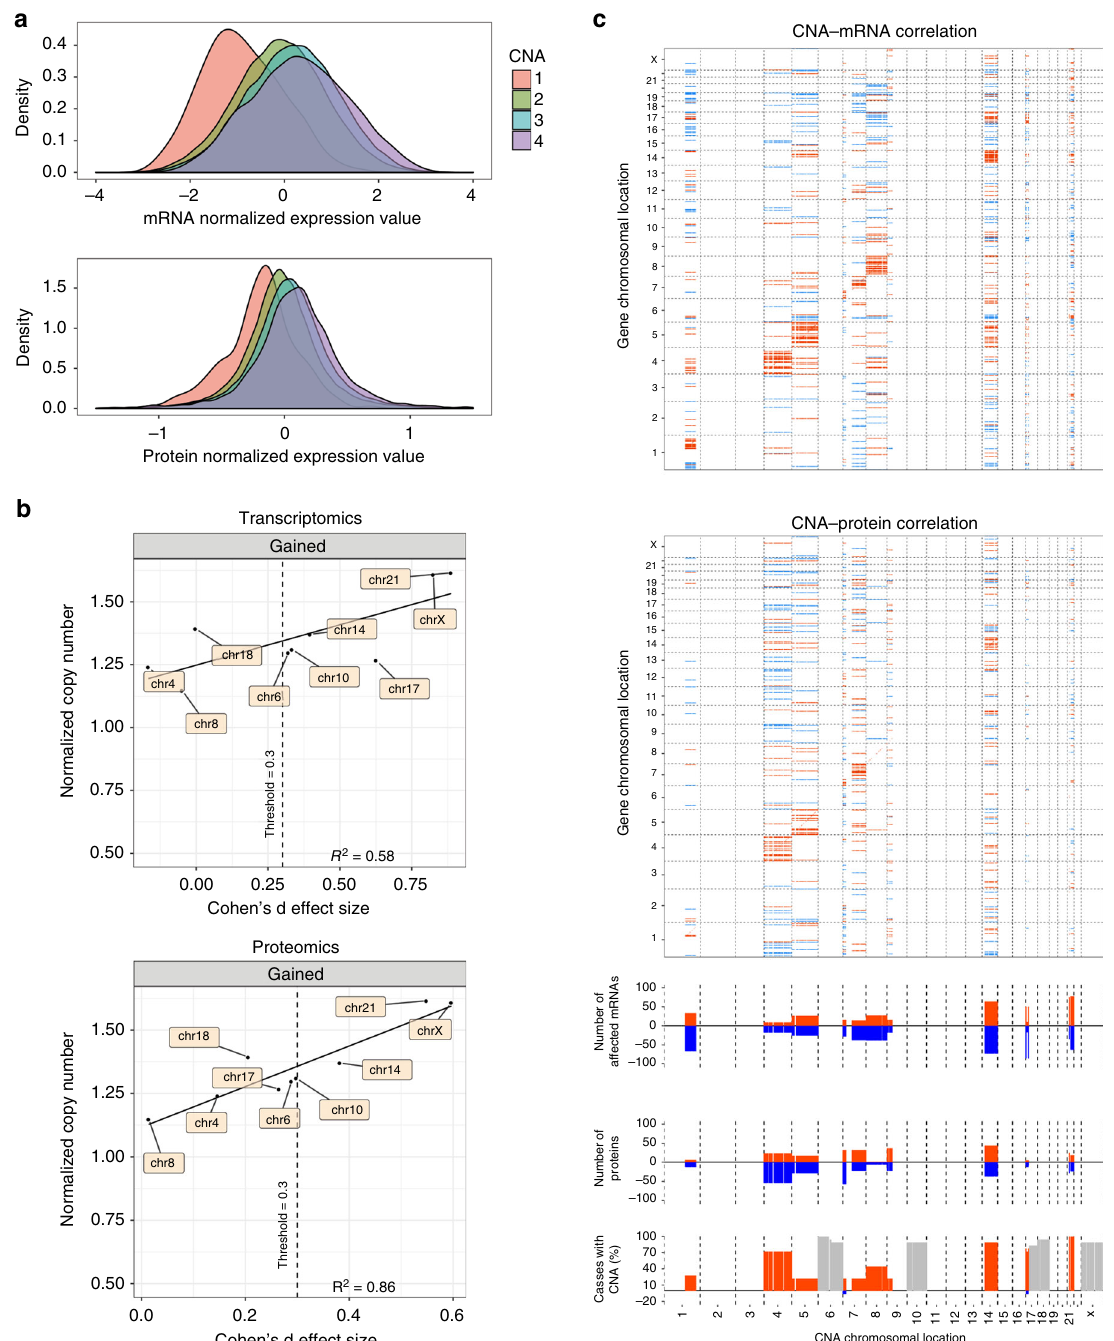
Fig. 2 Effects of copy number alterations on mRNA and protein abundance. a Dosage effects in 18 high hyperdiploid ALL at the RNA and protein levels. The effects were lower on the protein level than on RNA level, showing additional layers of control for protein expression. b Cohen ’ s d effect size analysis of gained chromosomes in high hyperdiploid vs. ETV6 / RUNX1 -positive leukemia. c cis and trans effects of copy number changes in 18 cases of hyperdiploid childhood B-cell precursor acute lymphoblastic leukemia. Correlations of copy number aberrations (CNA) ( x -axes) to RNA (top) and protein (bottom) expression levels ( y -axes) are shown. Note that a large fraction of the genome was not included in the analysis since there was no copy number variance, either because all cases had two copies or because all cases had three copies. Signi fi cant (multiple-test adjusted P < 0.05) positive (red) and negative (blue) correlations between CNA and mRNAs/proteins are indicated. CNA cis effects appear as a red diagonal line, CNA trans effects as vertical stripes. The fraction (%) of signi fi cant CNA trans effects (positive in red and negative in blue) for each CNA gene is shown below. The bottom panel shows the fraction (%) of leukemias harboring CNA (copy number gain in red and copy number loss in blue). Chromosomes that were gained in more than 16 cases were not informative; their copy number is shown in